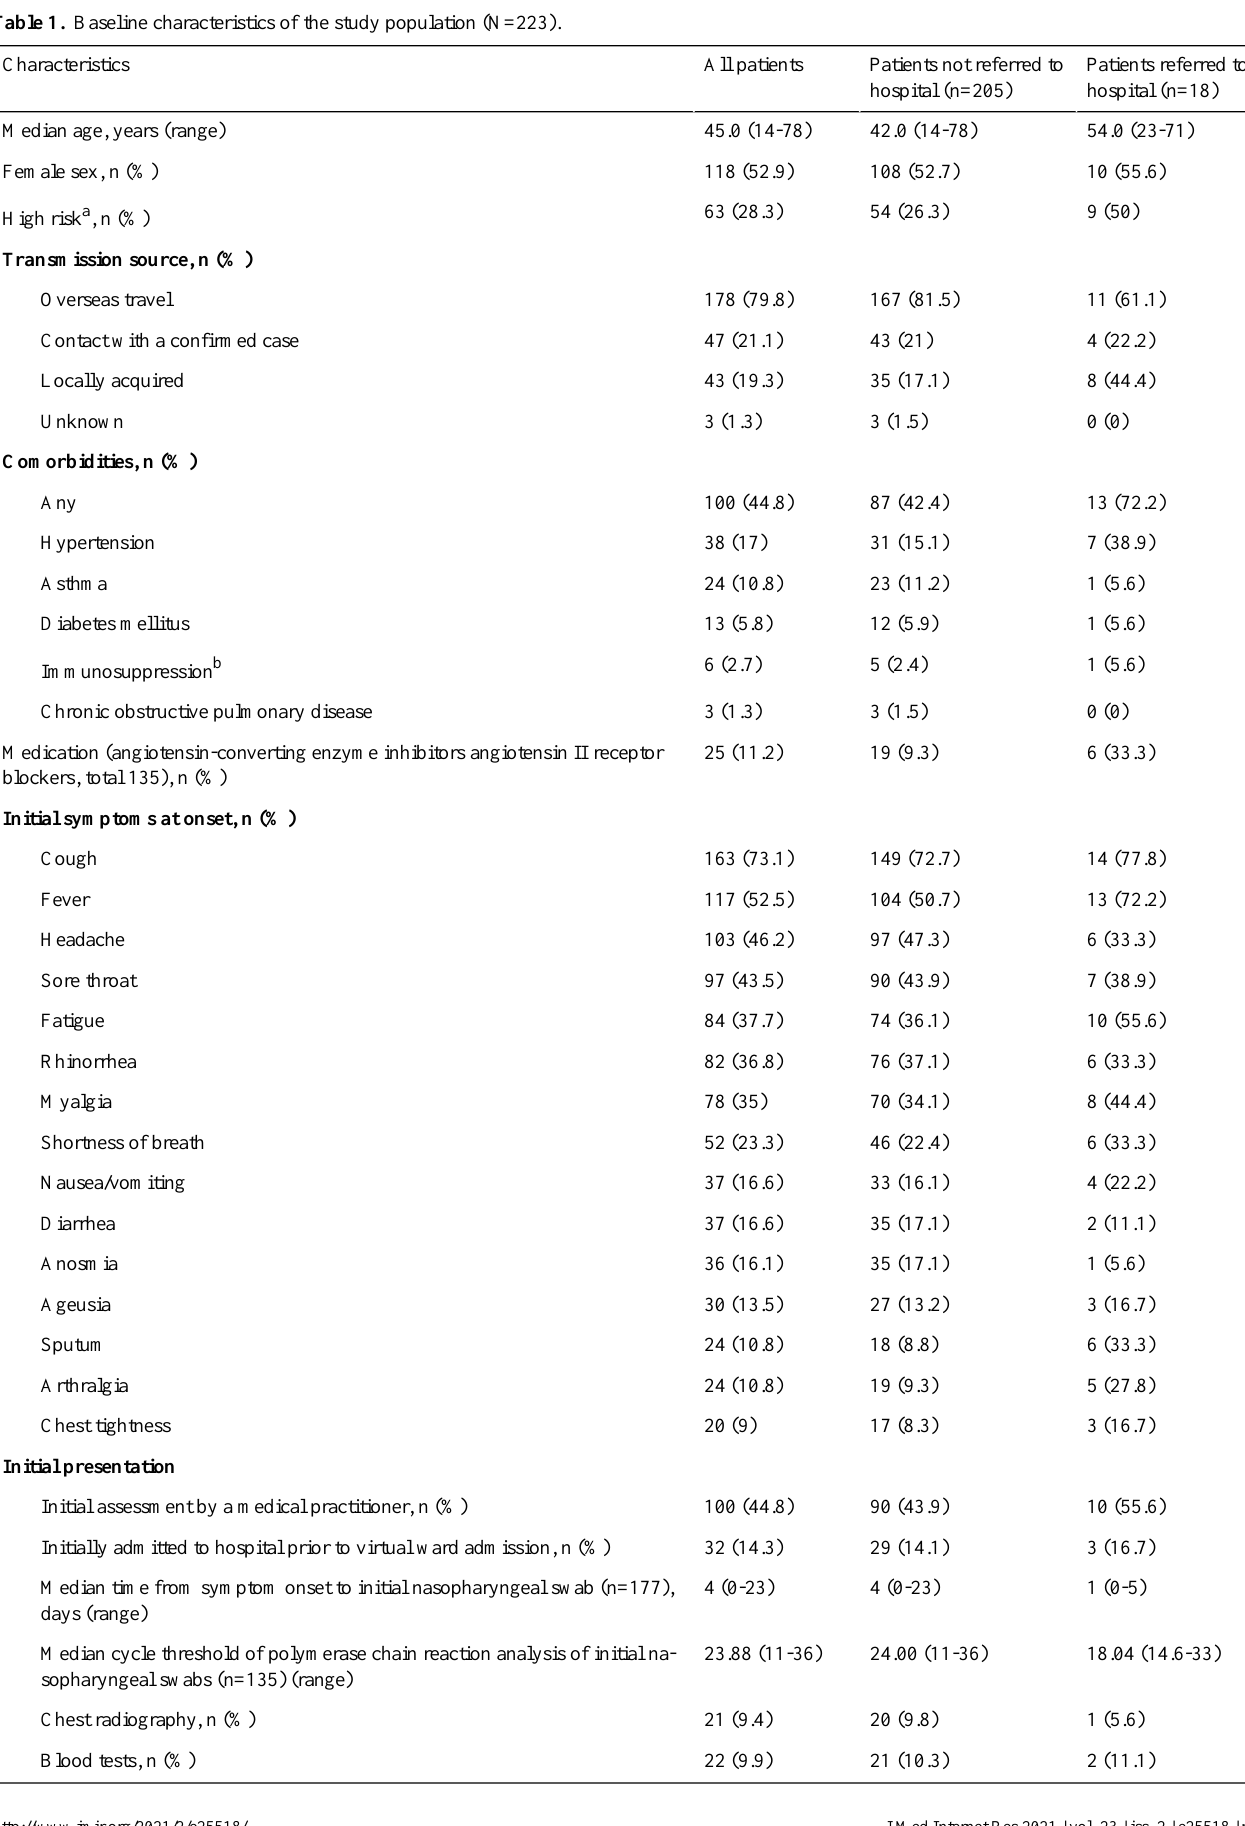
Table 1. Baseline characteristics of the study population (N=223).